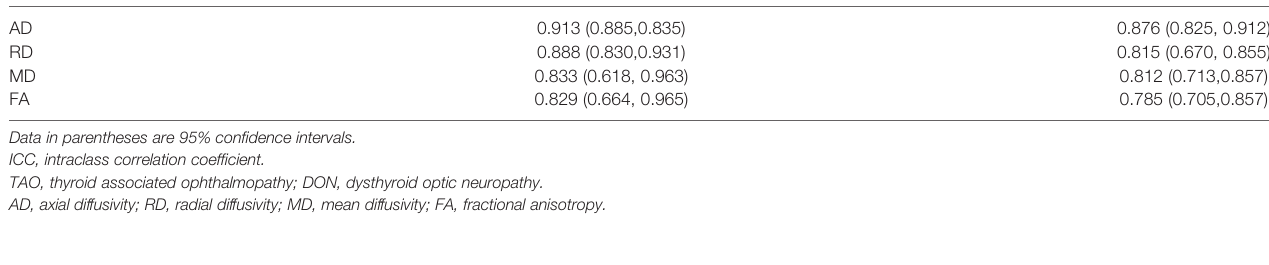
TABLE 2 | Interobserver agreement of DTI parameters. Parameters